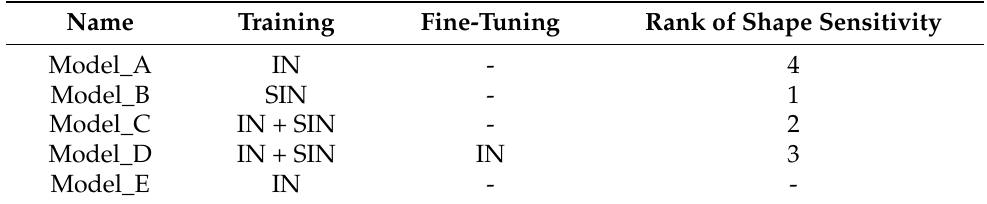
Table 1. The five different VGG19 CNN models used in this paper. IN and SIN are the abbreviations of ImageNet and Stylised-ImageNet,